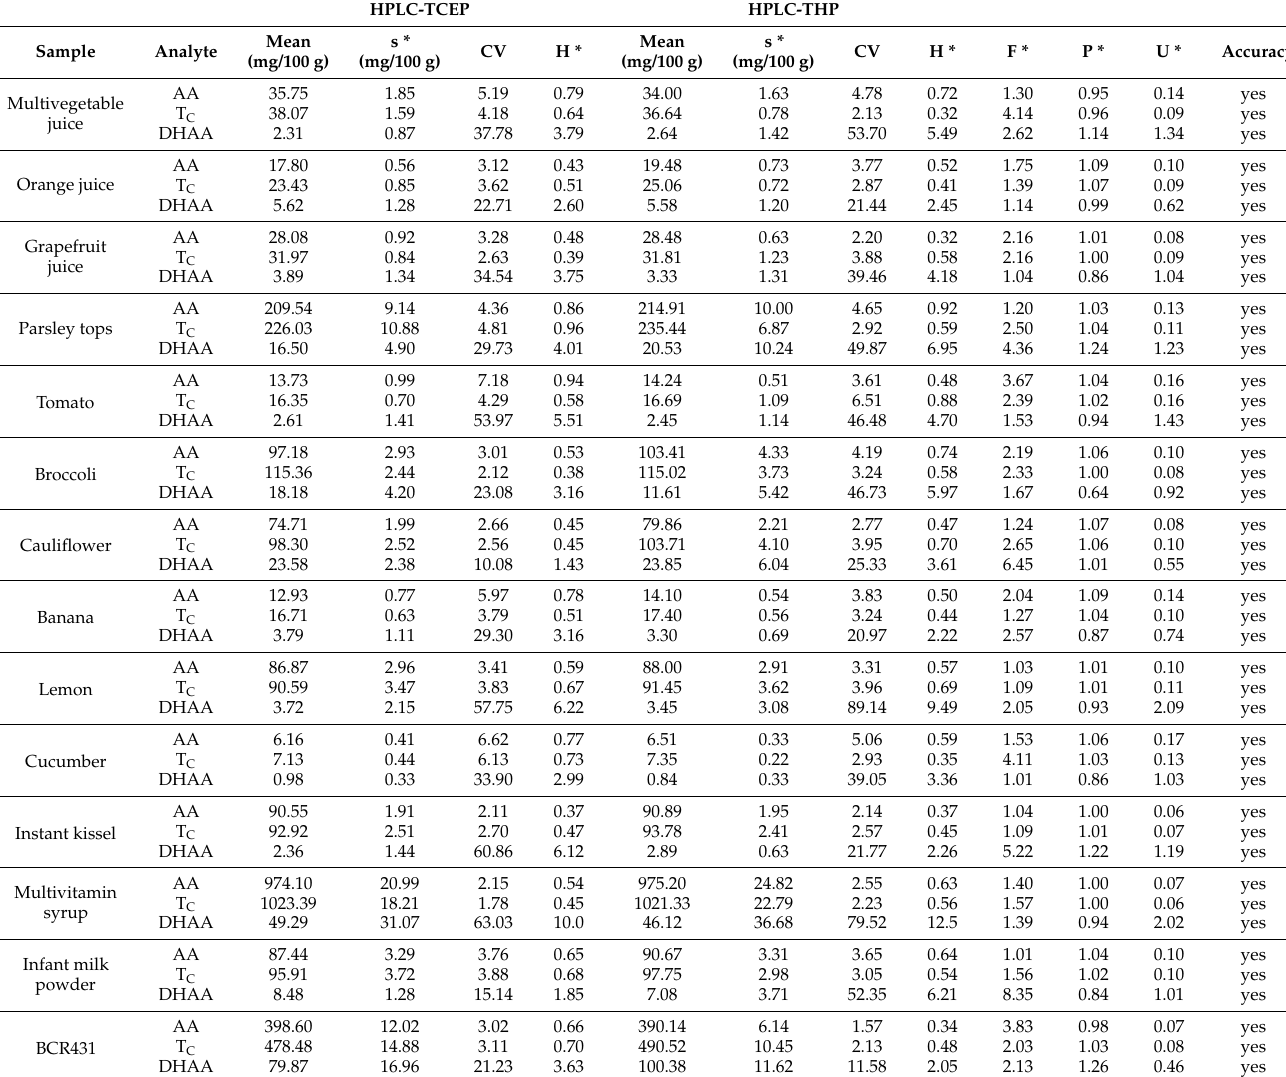
Table 1. Comparison of ascorbic acid (AA), total vitamin C (T C ) and dehydroascorbic acid (DHAA) values obtained by chromatographic method with the use of tris(2-carboxyethyl)phosphine (HPLC-TCEP) and tris(hydroxypropyl)phosphine (HPLC-THP) and statistical characteristics of the precision of determinations (F cr = 5.05 for α = 0.05 and f = 5).